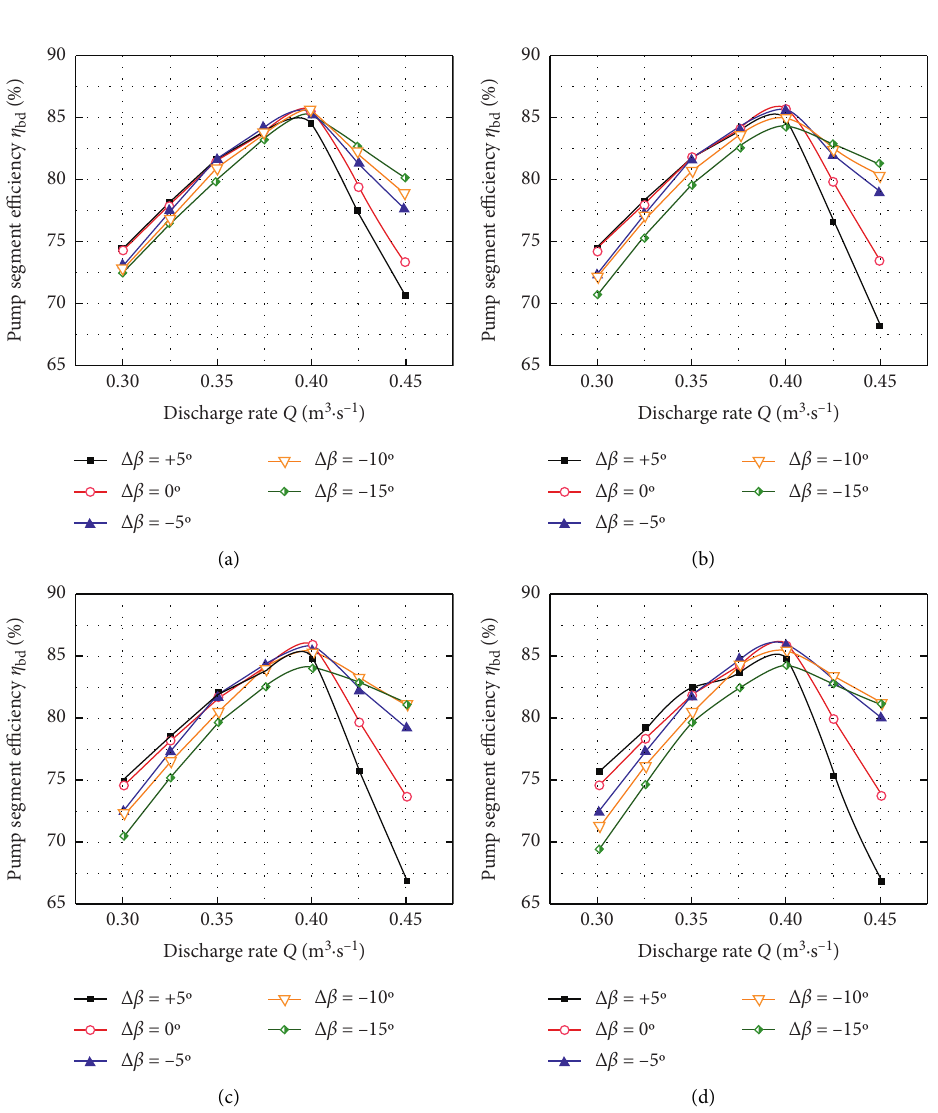
Figure 7: Q ∼ η bd curves for the different calculation schemes. (a) h